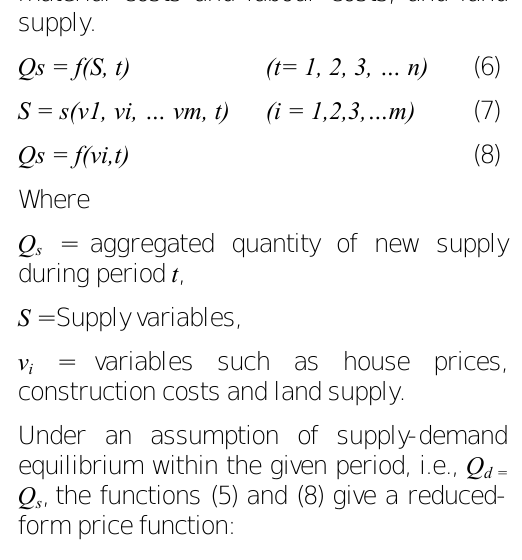
Table 3: The percentage distribution of households by expenditure Index Approximate